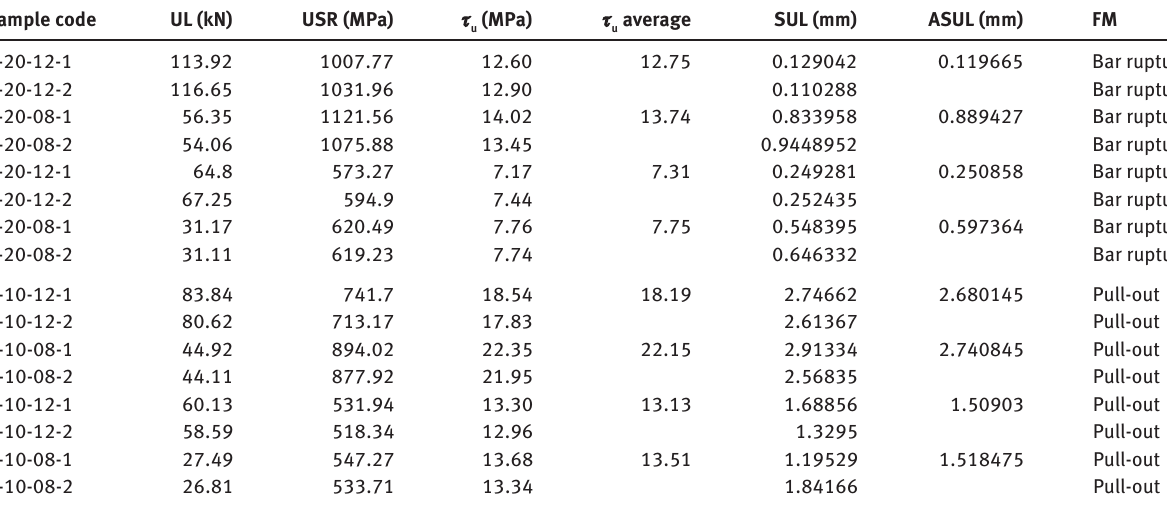
Table 5: Bond test results under hinged beam condition. Sample